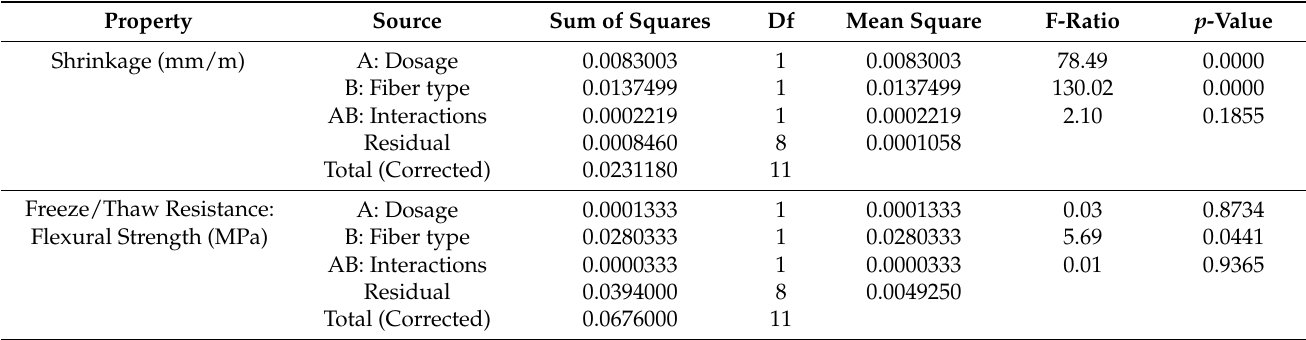
Table 15. Analysis of variance (ANOVA) for shrinkage and freezing tests.